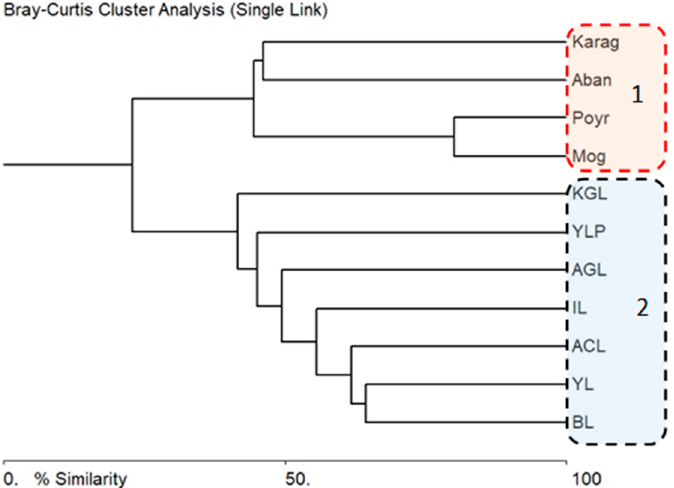
Figure 8. Bray-Curtis similarity analysis of species content in the Artabel Lakes in Gümü¸shane province (Artabel Lakes (ARL), Be¸s Lakes (BL), Yıldız Lakes (YL), Acembol Lakes (ACL), ˙Isimsiz Lake (IL), and Yıldız Lake (YLP)) according [42], the Avusor Great Lake (AGL), Koçdüzü Great Lake (KGL), and other lakes in northern Turkey (Mogan (Mog), Abant (Aban), Poyrazlar (Poyr), Karagol (Karag)) according [49].